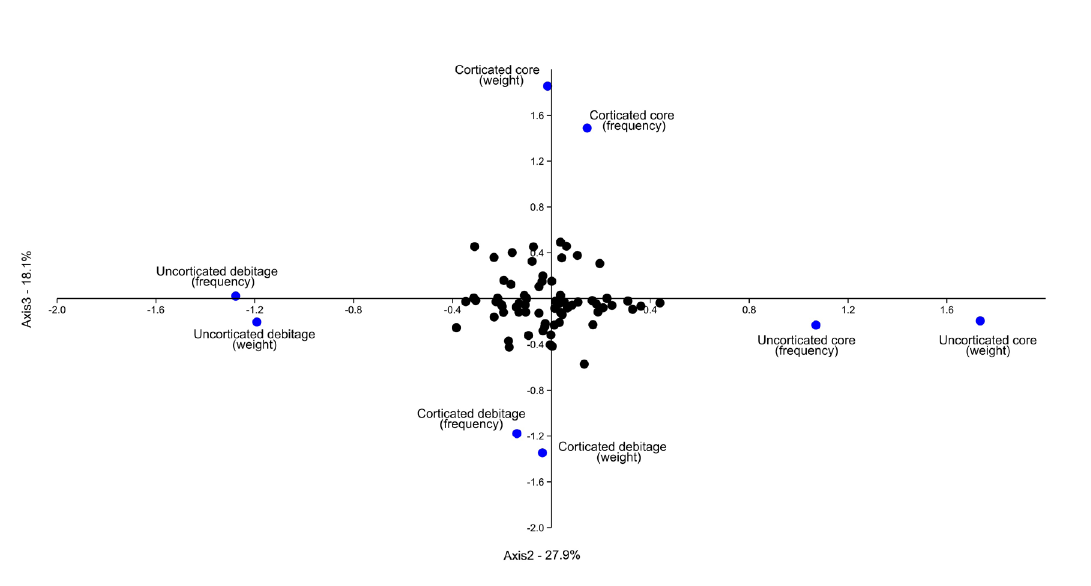
Figure 8: Correspondence analysis of Mezőzombor type limnosilicite and the plot according to the first and third